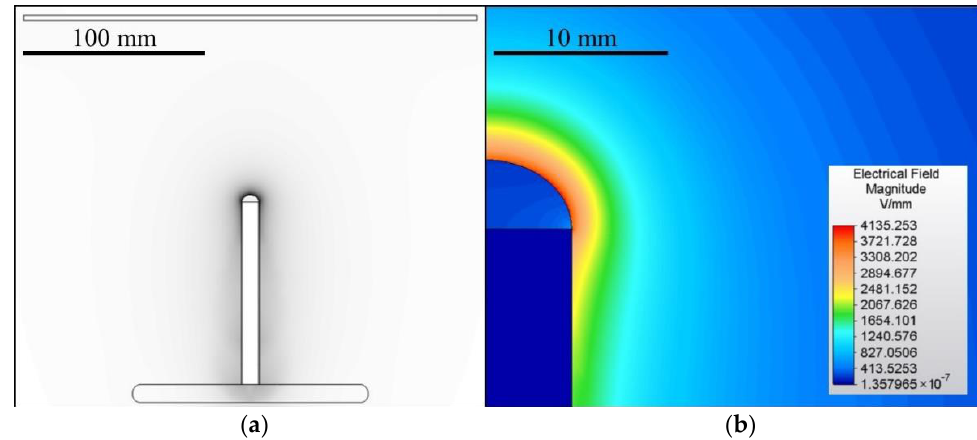
Figure 1. The geometry of the DC electrospinning system ( a ) and a detail of the corresponding electrostatic field ( b ). The spinning system for the AC tests applied the same geometry as the DC system but without a collector.